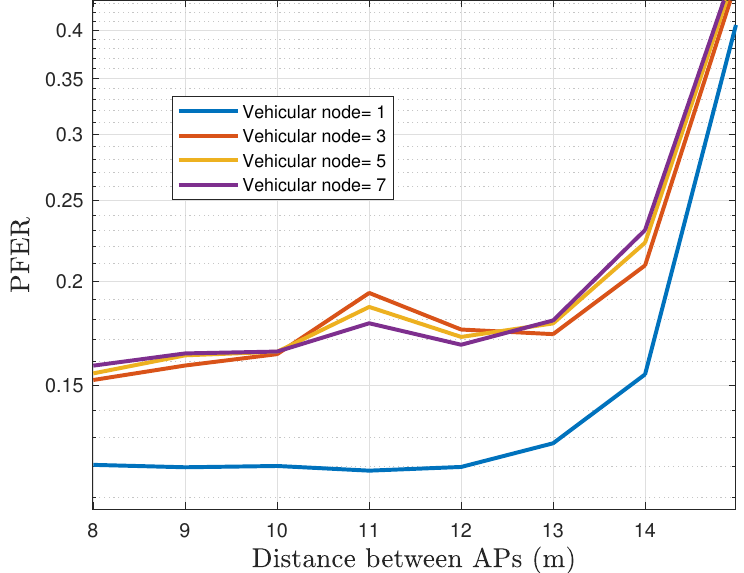
Figure 23. The PFER for different number of vehicular nodes operating in the network.